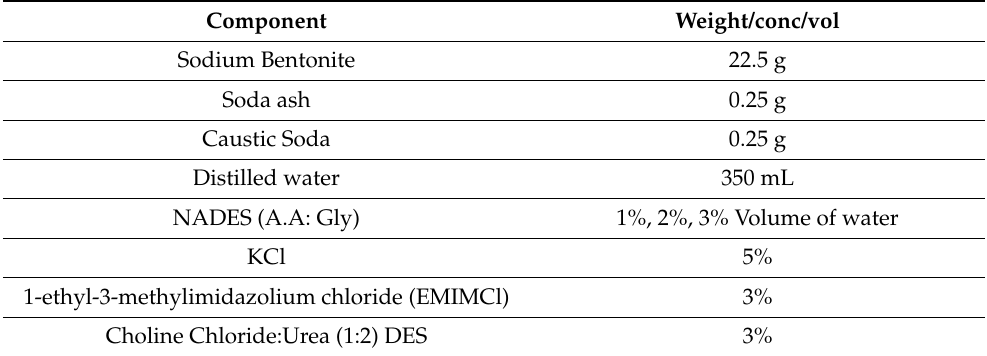
Table 2. Drilling mud composition.